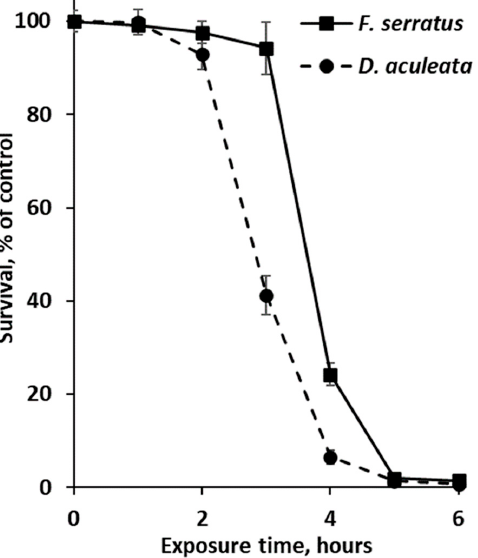
Figure 3. Survival curves of Escherichia coli cells in 0.9% NaCl solution supplemented with phlorotannin-enriched extracts of Fucus serratus and Desmarestia aculeata at the minimum inhibitory concentrations (20 and 5 μ g/mL, respectively). Means are given with ±SD ( n = 4).